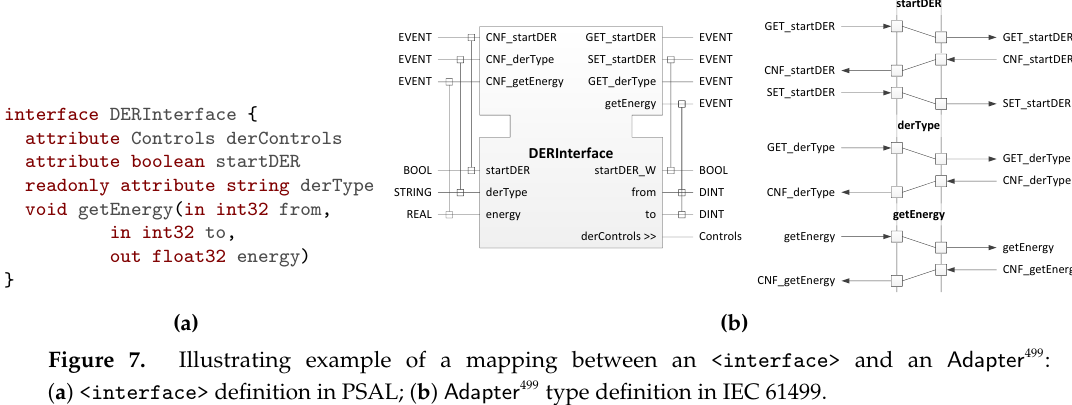
interface DERInterface { attribute Controls derControls